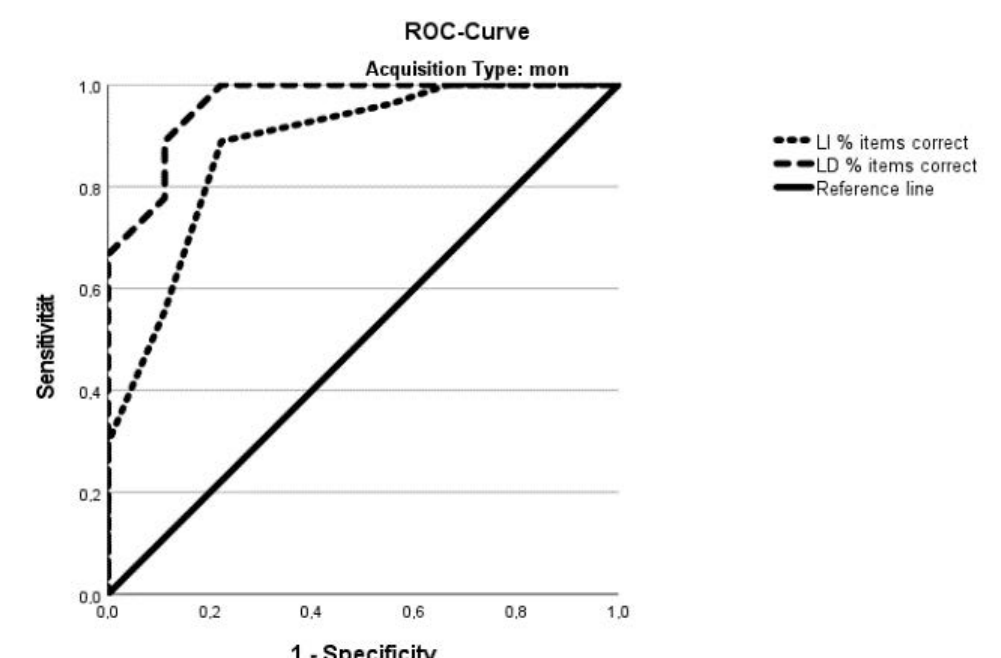
Figure 1. ROC curves for the language-independent (LI) and the language-dependent (LD) part for the monolingual group.